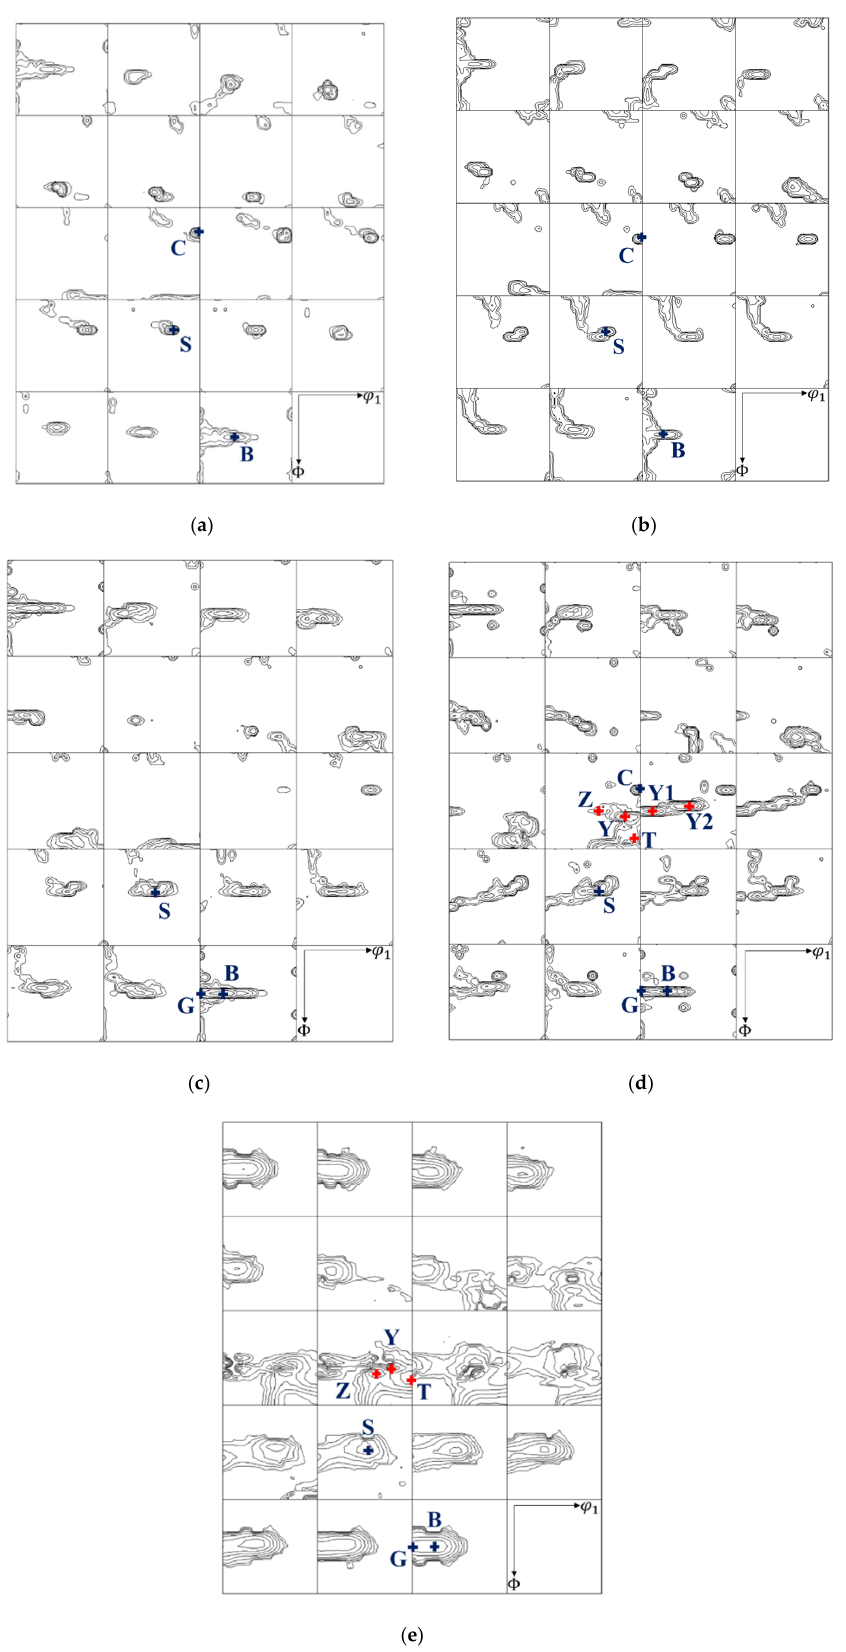
Figure 4. ODFs of fcc metals simulated using ( a ) FC-, ( b ) RC-, ( c ) MT-, and ( d ) MTCS-models with random orientations to 90% reduction. ( e ) ODF of 90% cold-rolled Cu–30%Zn from XRD measurements. The letters indicate specific orientations. Table 2. Major orientation components predicted with random orientations using FC-, RC-, MT-, and MTCS-models after 90% reduction.